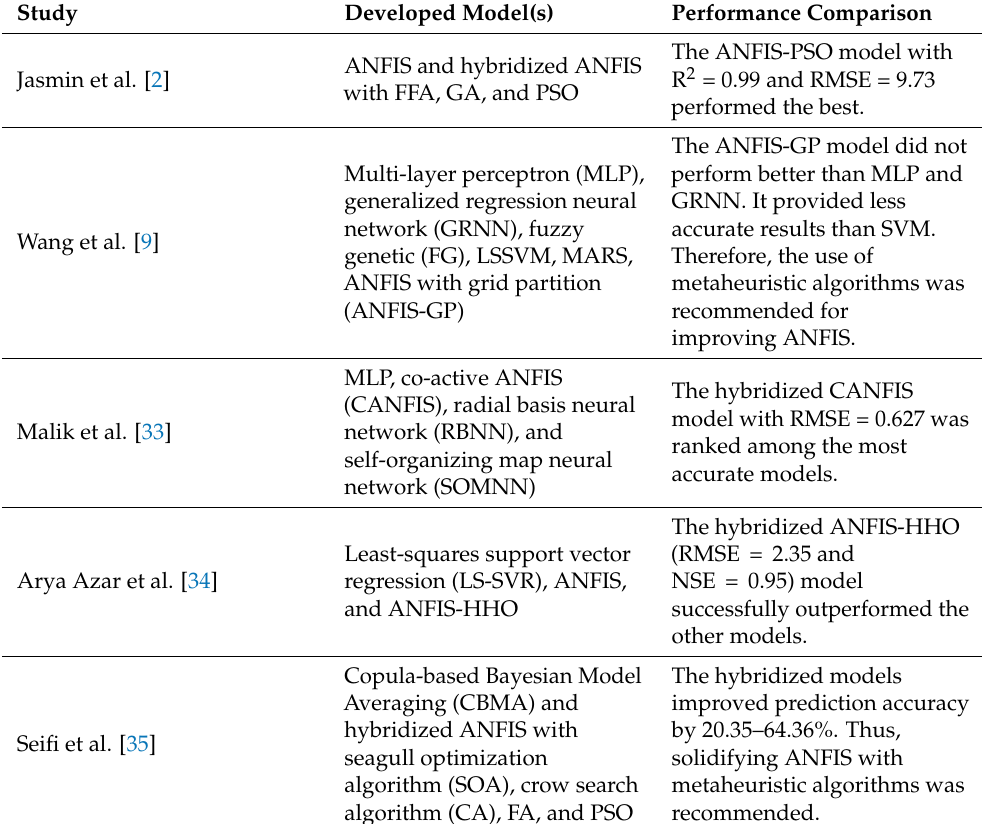
Table 1. Comparing the performance of standalone ANFIS, hybridized ANFIS with metaheuristic algorithms, and other ML models in modeling Epan based on the previous